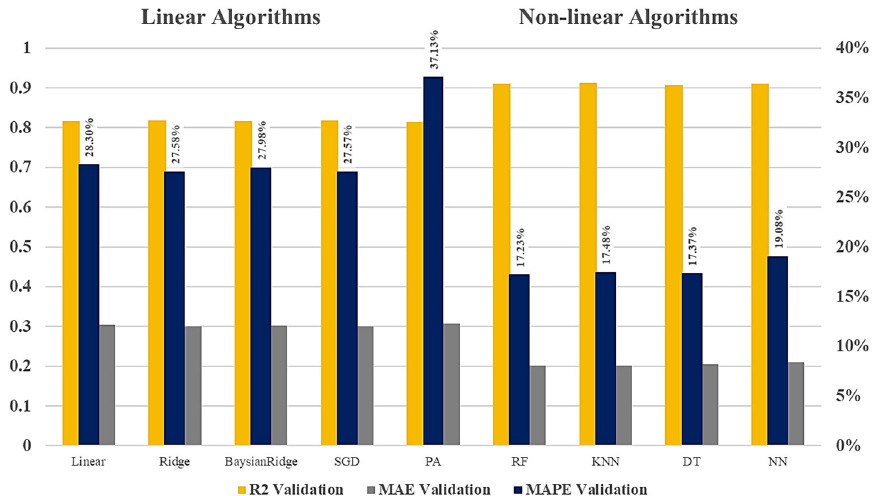
Figure 5. Comparison of different models: best performance on the validation data set (total number of cars).